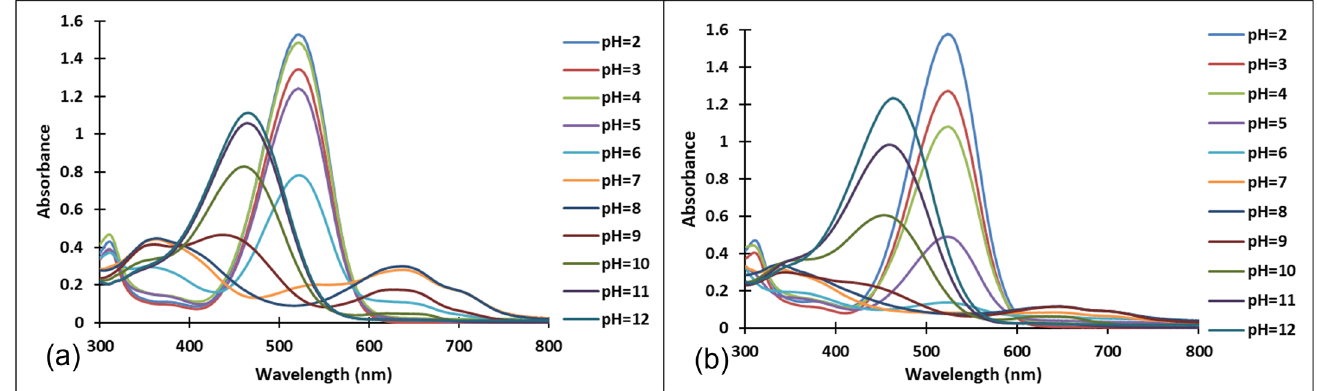
Figure 5. Absorption spectra of the species derived from compound 4 after ( a ) 40 min and ( b ) 72 h at different pH values.